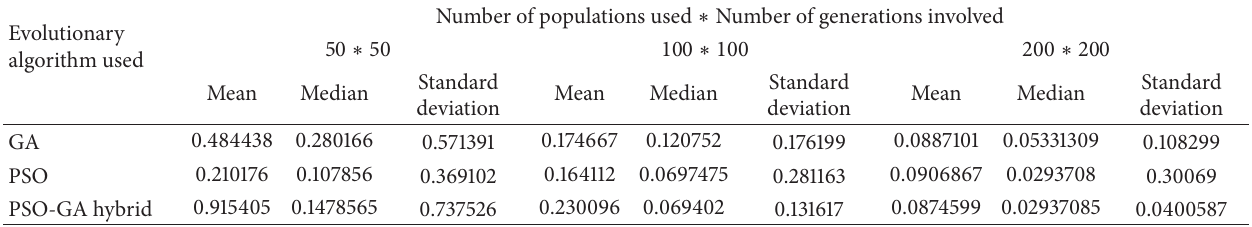
Table 1: Comparative results for approximating 3rd order differentiator by different evolutionary optimization algorithms. Evolutionary algorithm used